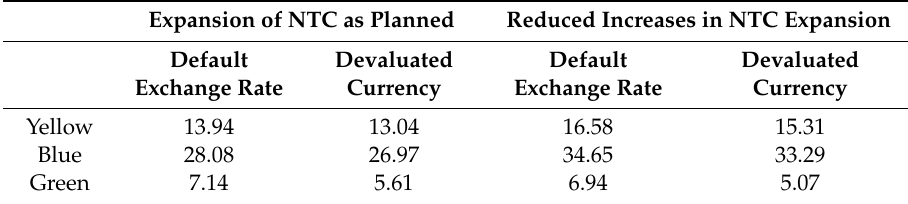
Table 6. Average price spread in € per MWh. Source: Own calculation.